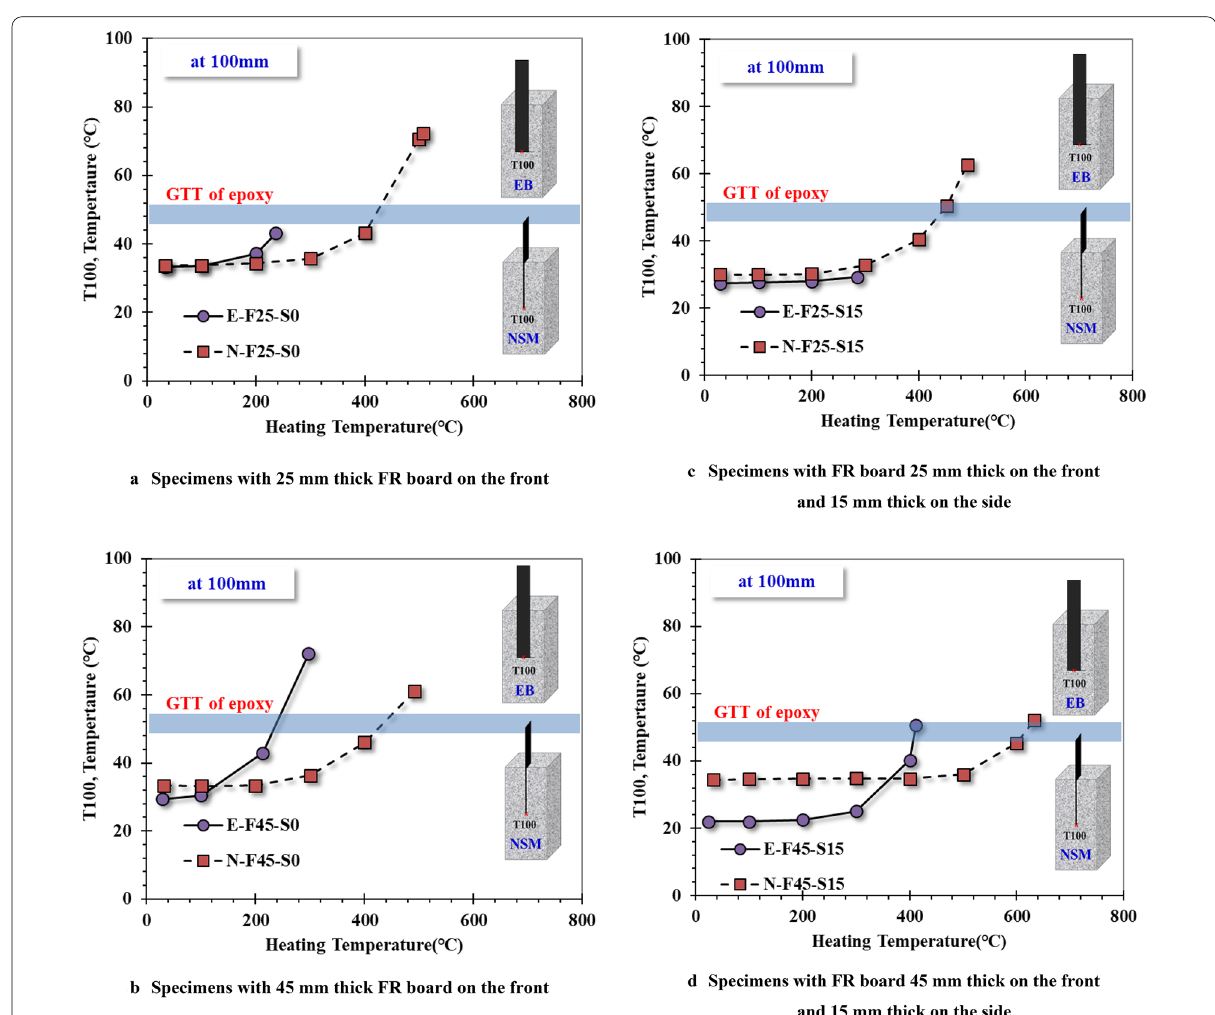
Fig. 20 Comparison of temperature profiles of epoxy between EB and NSM